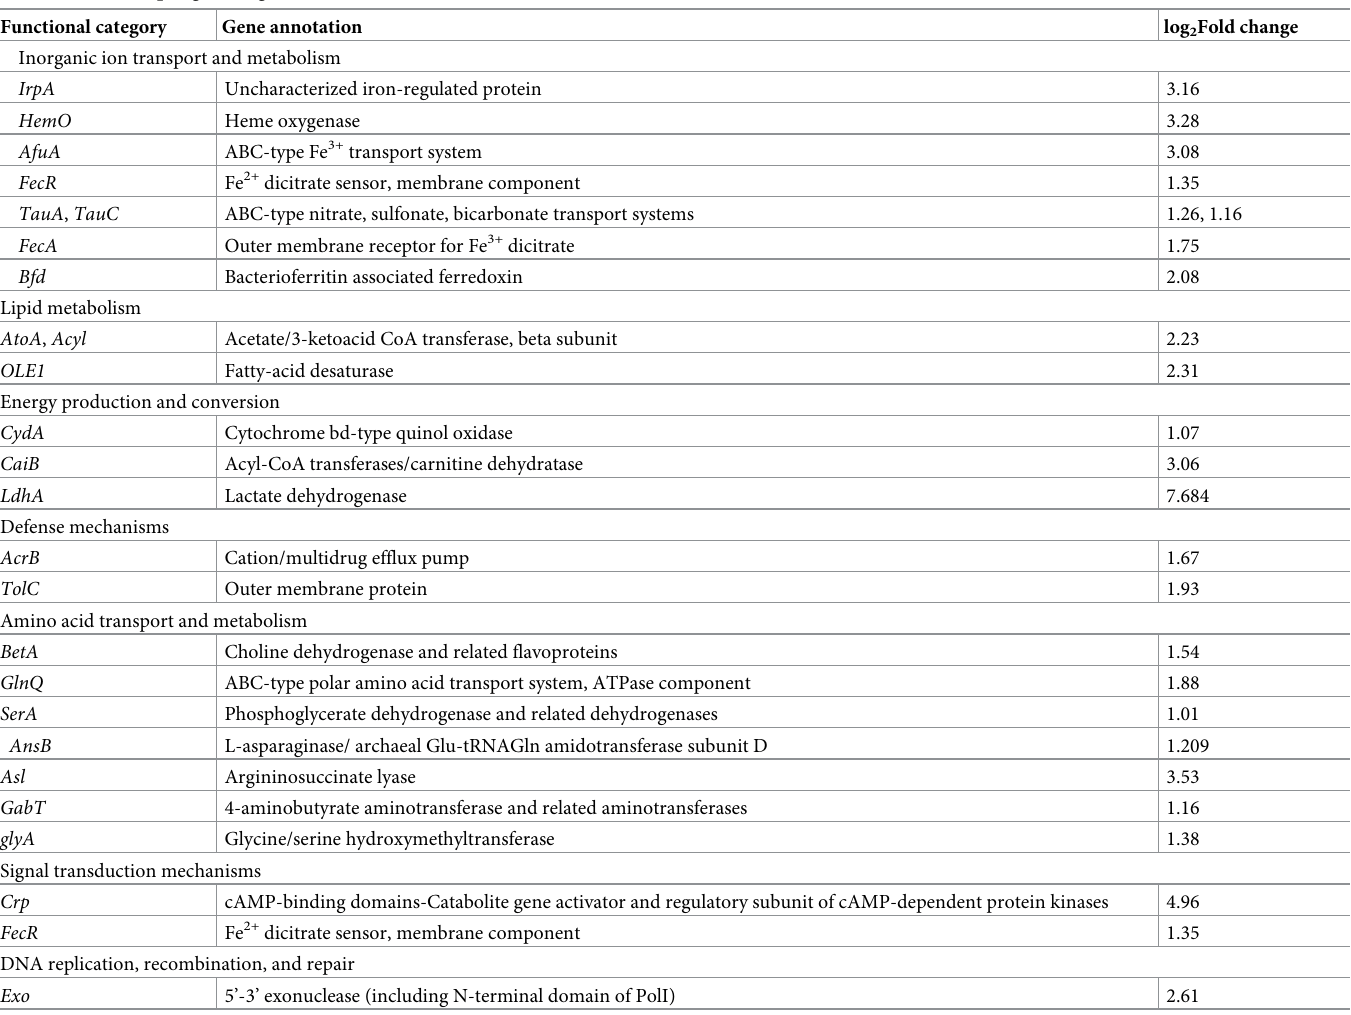
Table 3. Selected up-regulated genes under Cr(VI) stress in strain